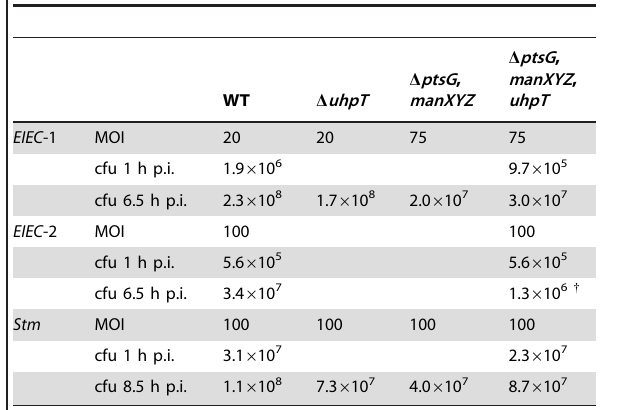
Table 1. Infection conditions used in this study.